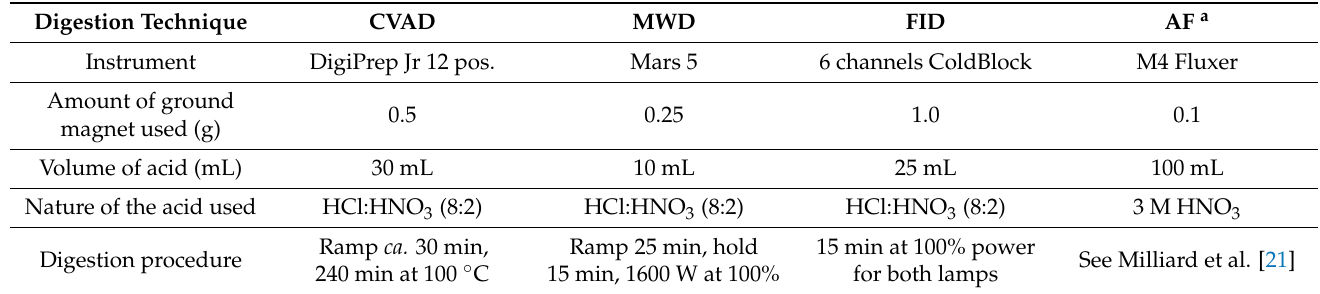
Table 3. Operating conditions used for the complete dissolution of ground magnets.